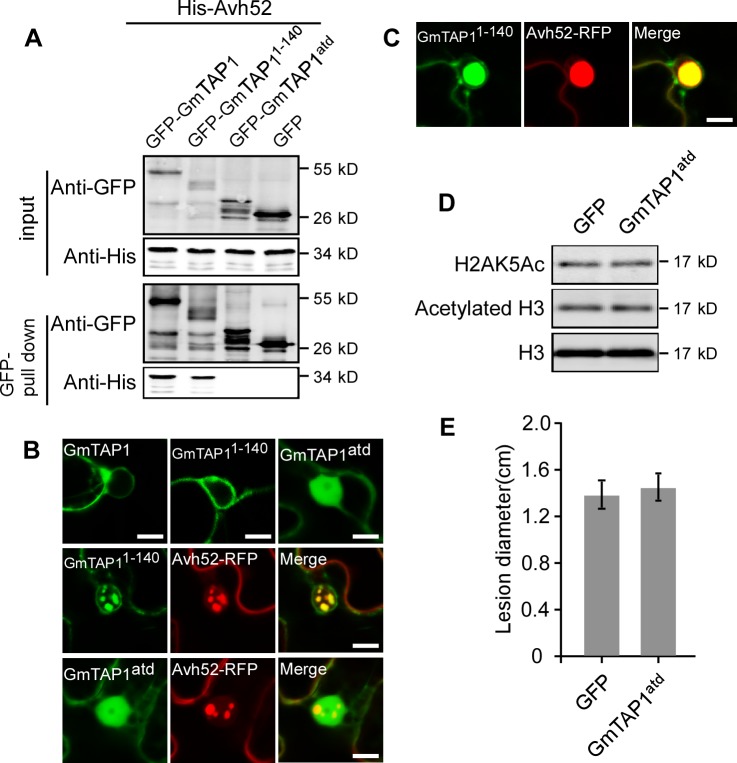
Interaction and co-localization of the N-terminal and C-terminal domains of GmTAP1 with PsAvh52.(A) Pull down of His-Avh52 by GFP fusions of various GmTAP1 domains. GFP-GmTAP1 fusions and GFP were purified from N. benthamiana, and His-Avh52 was purified from E. coli. (B) Localization of indicated GFP-GmTAP1 proteins in the absence (upper) or presence (the two lower) of PsAvh52-RFP after expression in N. benthamiana cells. Scale bars = 10 µm. (C) Localization of PsAvh52 and GmTAP11-140 after extended co-expression (36 hr to 48 hr) in N. benthamiana leaf cells. Scale bars = 10 µm. (D) In vivo histone acetylation assays following expression of GmTAP1atd in N. benthamiana leaves. Histone acetylation was detected by western blotting. This experiment was repeated three times with similar results. (E) Susceptibility of N. benthamiana leaves to P. capsici infection following transient 48 hr expression of GmTAP1atd. Data are the means ± s.d. of three independent biological replicates. No significant differences were observed based on Student’s t test.